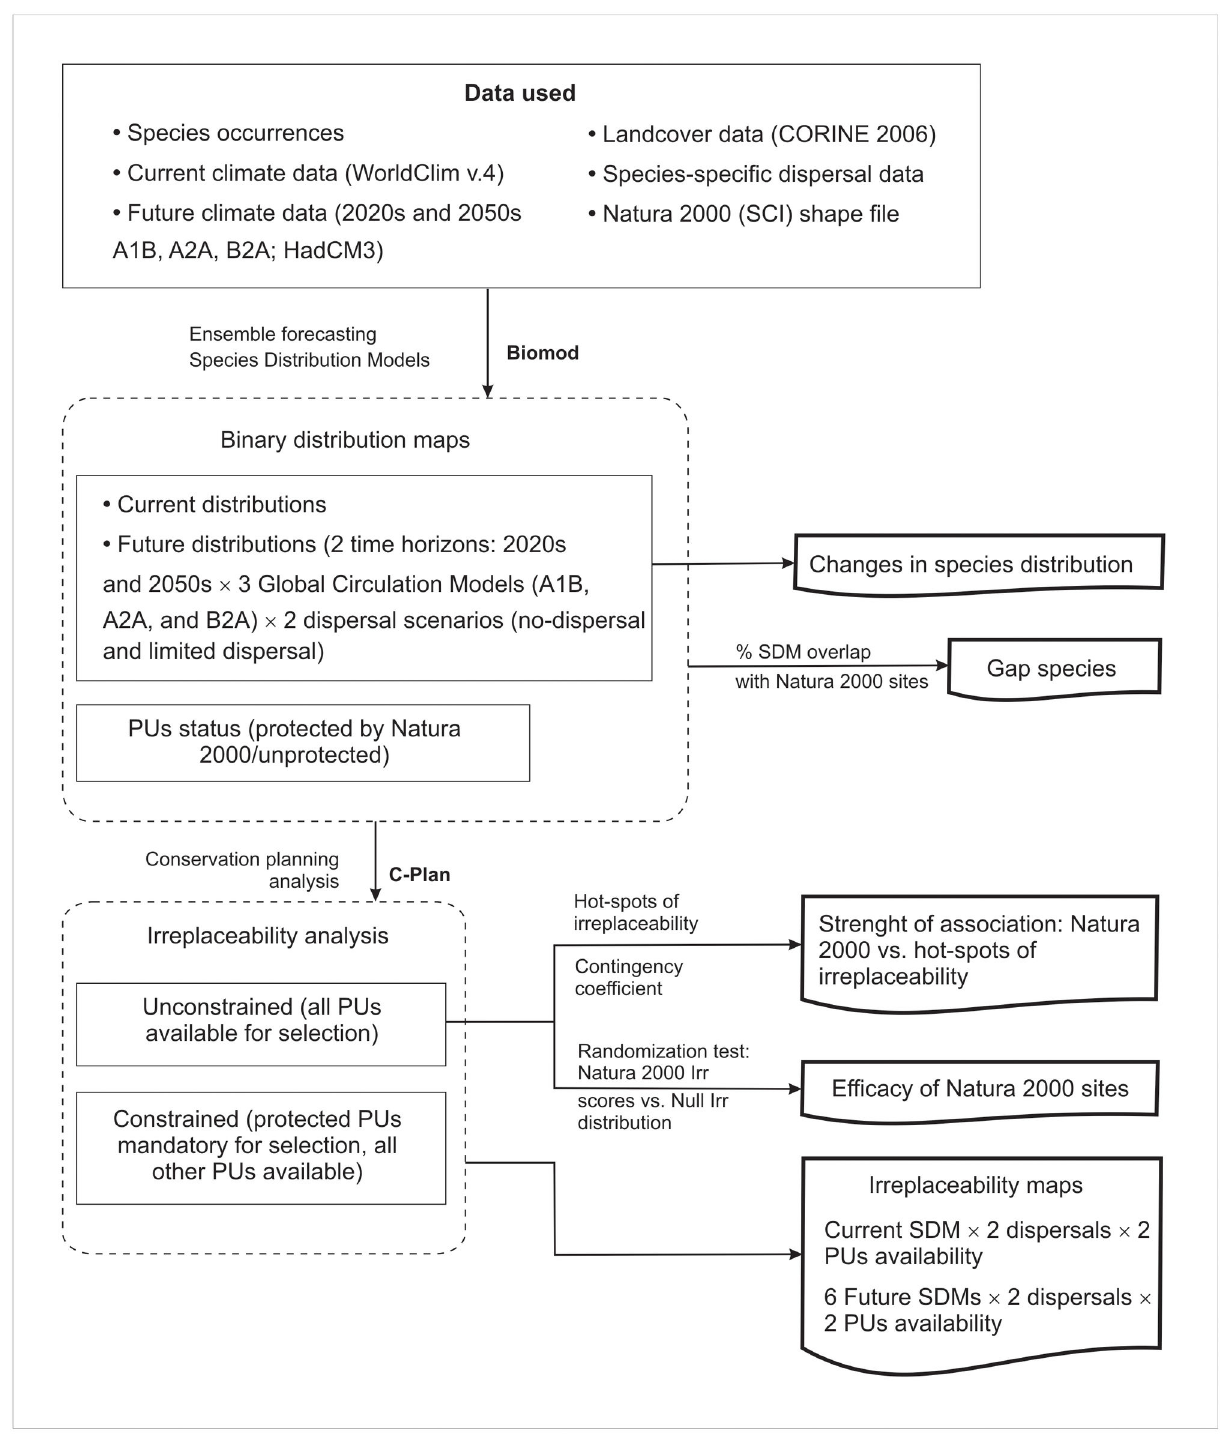
Figure 1. Flowchart of stages of analysis and data inputs.